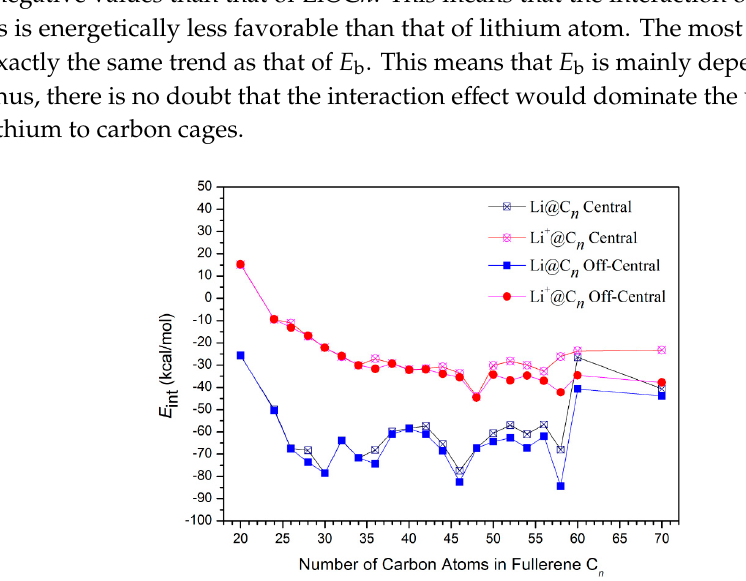
Figure 4. RDG of Li@C n ( up ) and Li + @C n ( down ). We also perform energy decomposition analysis (EDA) analysis in order to quantitatively describe the host-guest interaction for various Li-based endohedral fullerenes. For our purposes, E int is decomposed to E els , E ex , E orb , and E dis parts. Of these, E els is the electrostatic part, describing the electrostatic interaction between the two monomers which contribute to the electronic density of the two isolated monomers directly superimposed; E ex is the exchange repulsion term which designates the Pauli interaction, and shows a “repulsive” effect between the occupied orbit of one fragment and the occupied orbit of another; this repulsive effect results in an increase in the total energy, and in